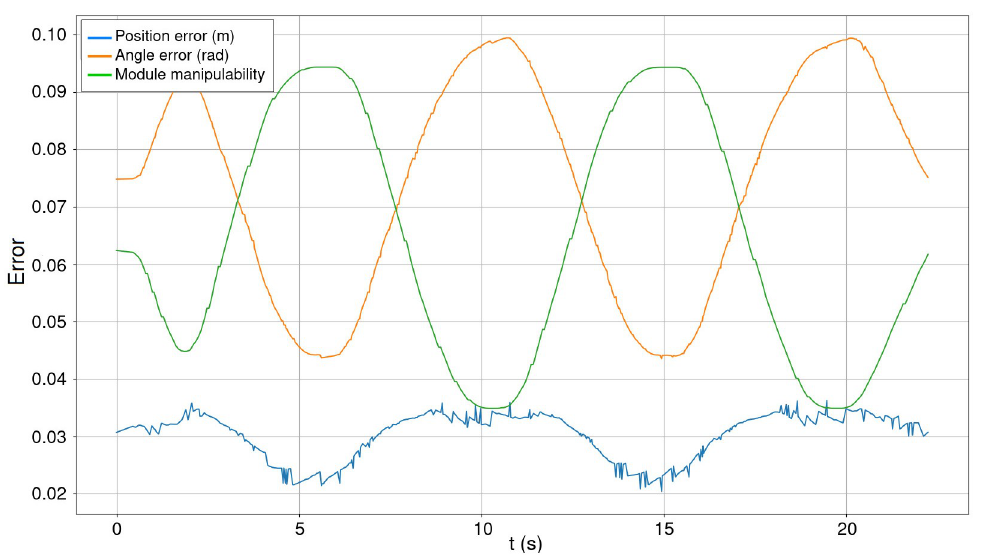
Figure 11. Module manipulability over the angular and distance error of the estimation that a module does during a circular trajectory (Figure 8). Manipulability line has been scaled for represent- ation